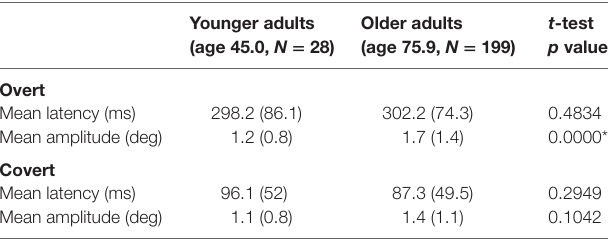
TaBle 1 | Mean (sD) compensatory (overt, covert) saccade latency and amplitude for younger and older adults.